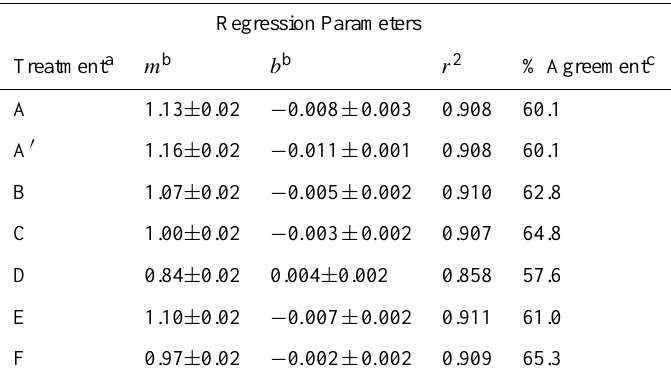
Table 4. Quantitative comparison between GC-FID and PTR-MS toluene measurements for different monoterpene fragmentation corrections applied to the PTR-MS data. Regression Parameters